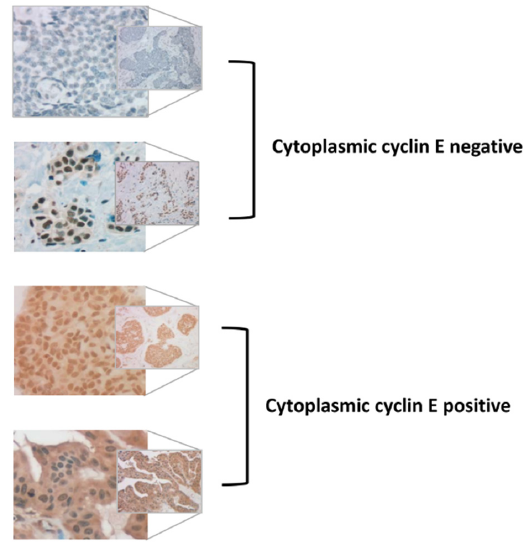
Figure 2. Representative images of positive and negative staining for cytoplasmic cyclin E using antibody C-19. antibody